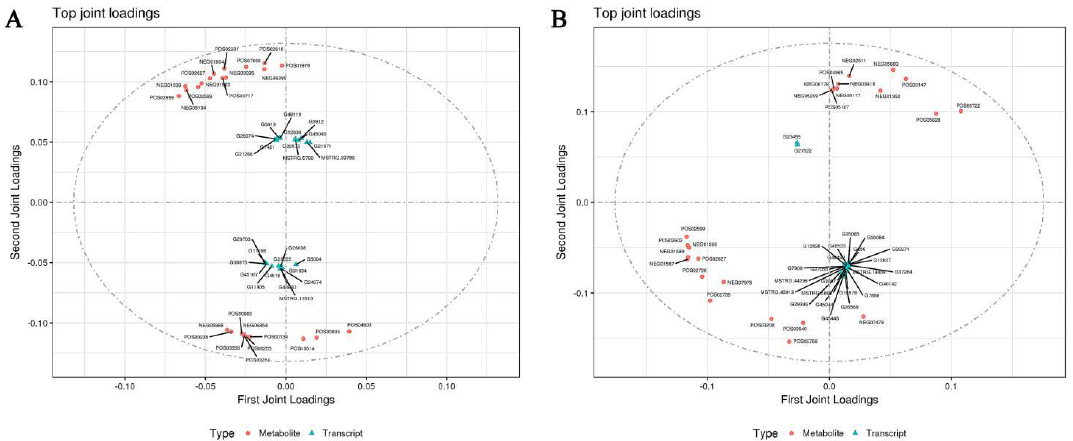
Figure 10. Correlation analysis of DEGs and DAMs. Correlation analysis of DEGs and DAMs in ( A ) S1 and ( B ) S2, respectively. In the picture, the orange dots represent DAMs, and the blue triangles represent DEGs. The top 25 DEGs and DAMs with high correlation were marked in the figure.